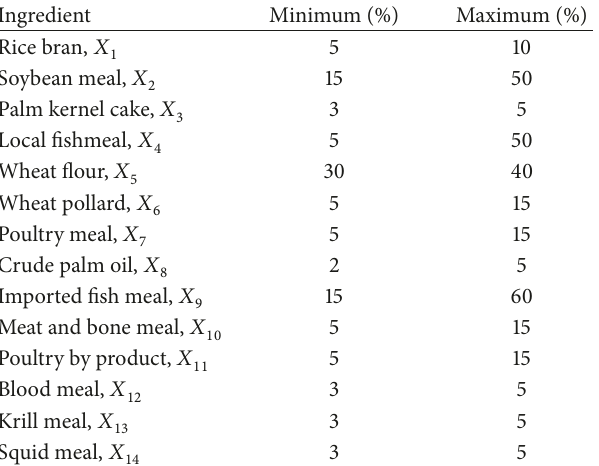
Table 2: A list of ingredients and its specific range.